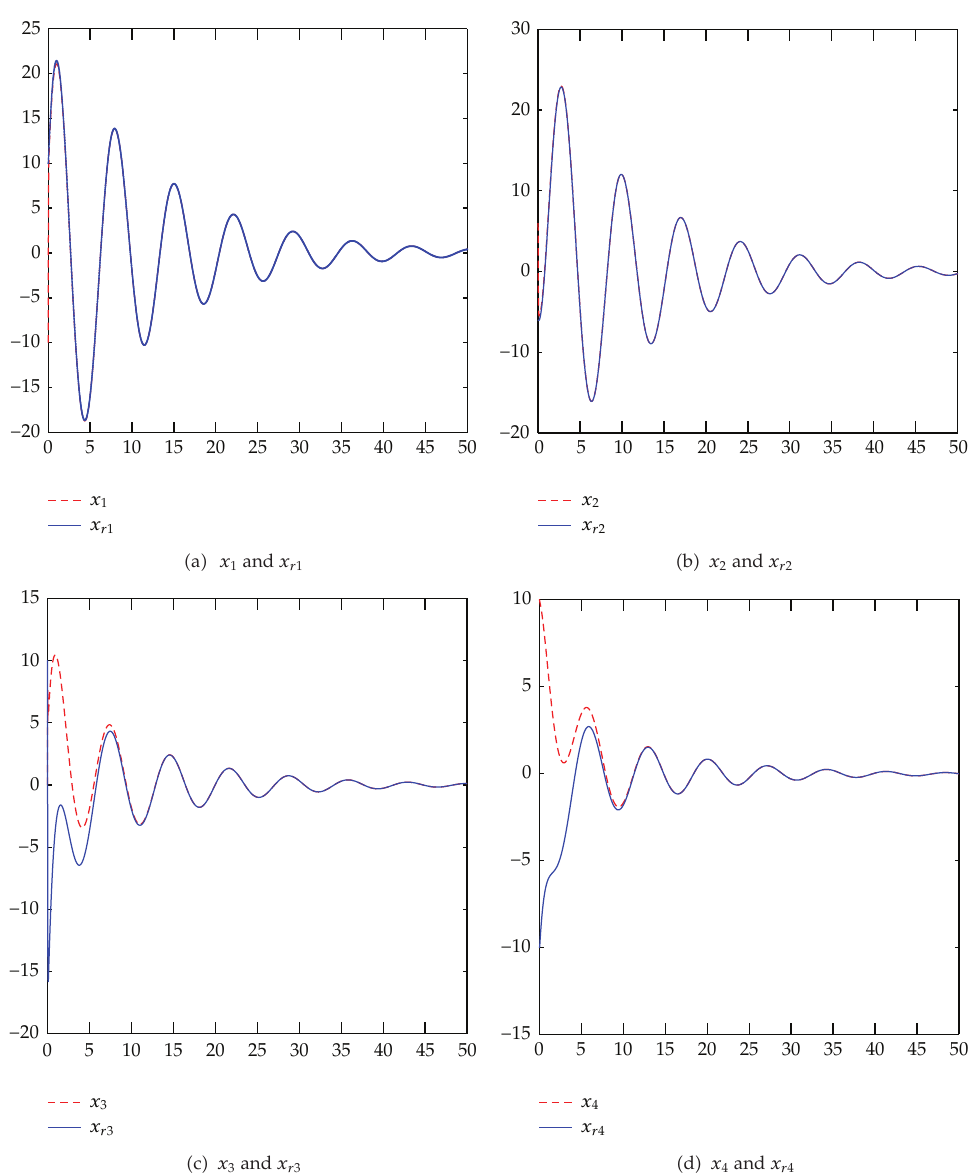
Figure 1: Comparison of the corresponding variables in the controlled hyperchaotic R¨ossler system and its reference system: (cid:6) a (cid:7) x 1 and x r 1 ; (cid:6) b (cid:7) x 2 and x r 2 ; (cid:6) c (cid:7) x 3 and x r 3 ; (cid:6) d (cid:7) x 4 and x r 4